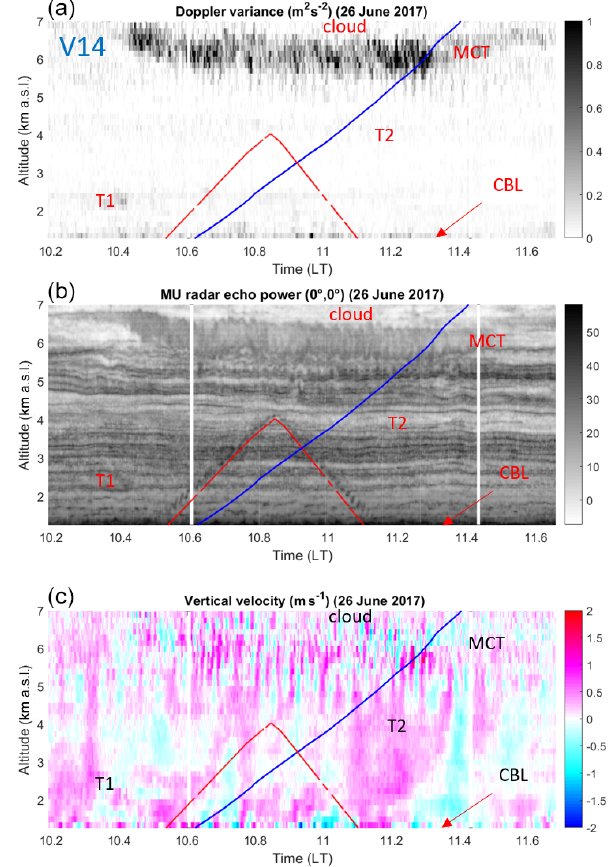
Figure 2. (a) Time–height cross section of variance of the Doppler spectrum peaks corrected from the beam-broadening effects ob- tained from MU radar measurements during balloon flight V14 and UAV flight SH29. The altitudes of V14 and SH29 vs. time are given by blue and red lines, respectively. (b) Same as top for radar echo power (dB) in range imaging mode. (c) Same as top for vertical ve- locity (ms − 1 ). The white vertical lines are due to radar stops. See, e.g., Luce et al. (2018) for more details about these figures. Labels refer to the location of turbulent